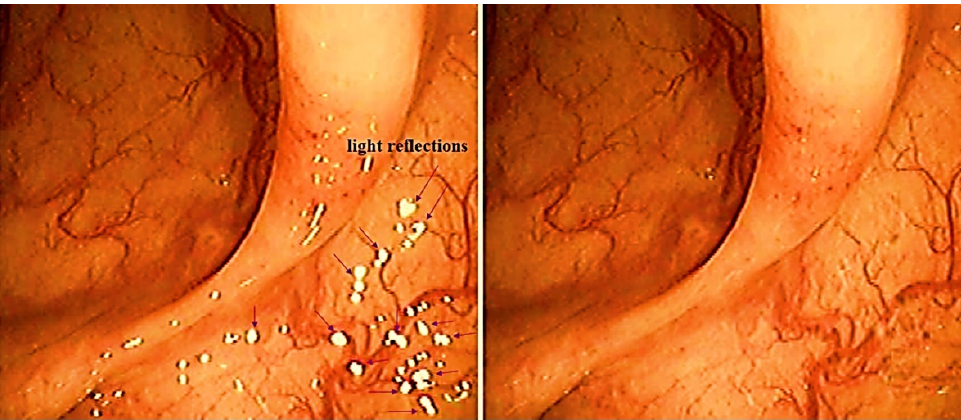
Figure 2. Creation of specular reflection through the LED with colon endoscopy and specular reflection removal. reflection